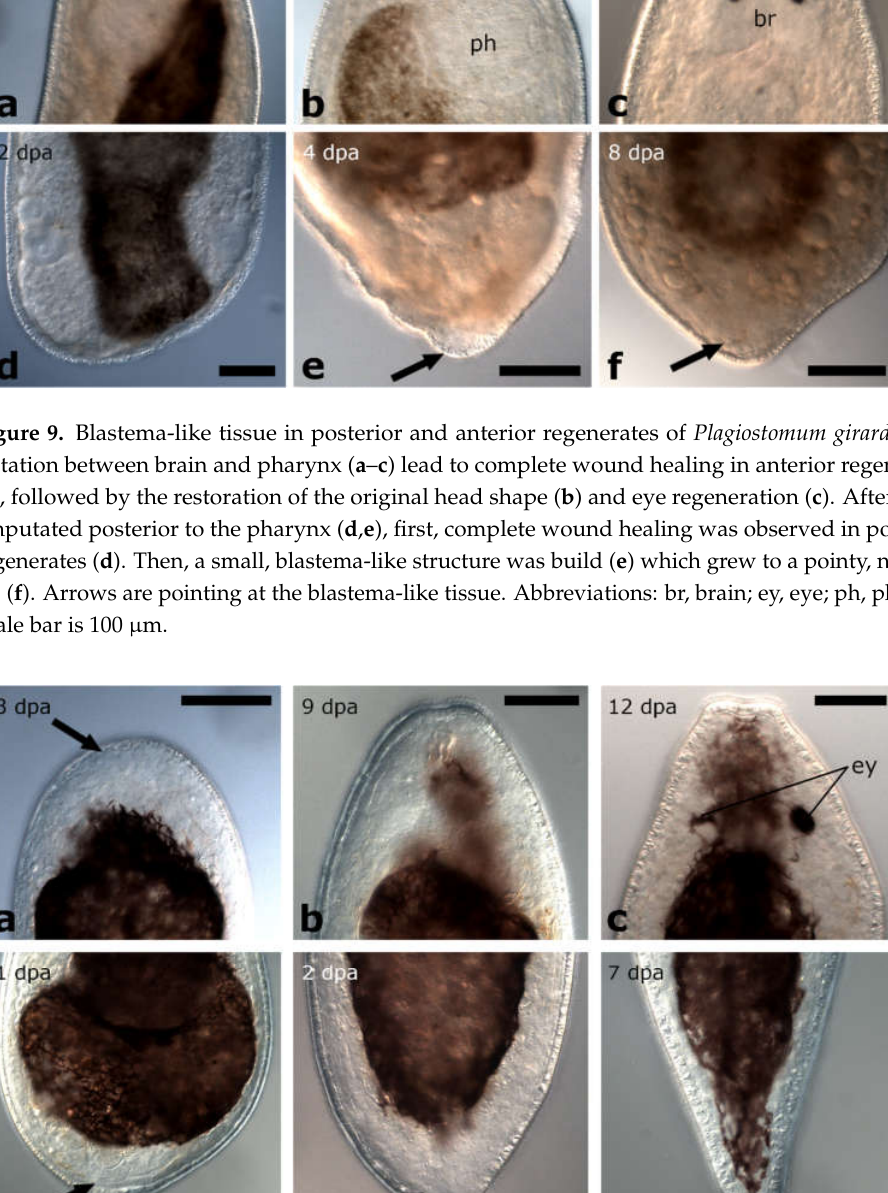
Figure 10. Blastema-like tissue in in posterior and anterior regenerates of Vorticeros auriculatum . Am- putation between brain and pharynx ( a–c ) and amputation posterior to the pharynx ( d–f ). Anterior regenerates ( a ) and posterior regenerates ( d ) fully healed the wound and build a blastema-like struc- ture at the wound site. First, the original shape of the head ( b ) and the tail ( e ) was restored before the eyes ( c ) and the pigmentation ( c and f ) were regenerated. Arrows are pointing at the blastema- like tissue. Abbreviations: ey, eye. Scale bar is 100 µm in ( a) and 50 µm in ( b–f) .